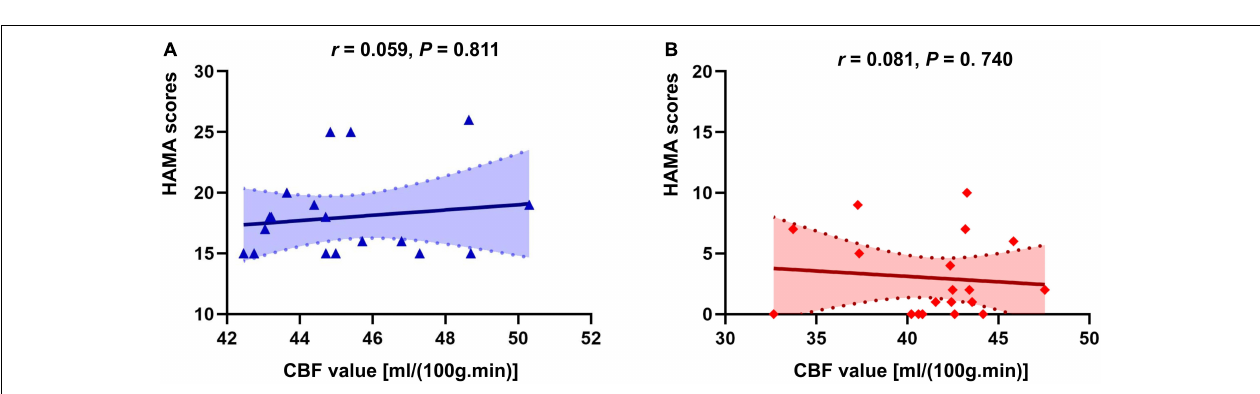
FIGURE 5 | Correlation analysis of CBF in brain regions with difference (Postcentral_R) and HAMA score in two groups. (A) The correlation analysis in anxiety group. (B) The correlation analysis in non-anxiety group.